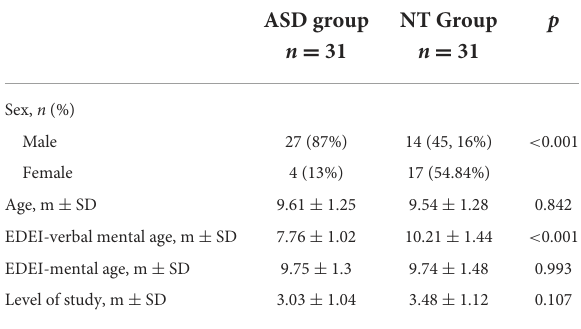
Children and Adolescents (MINI-KID) and had no family history of